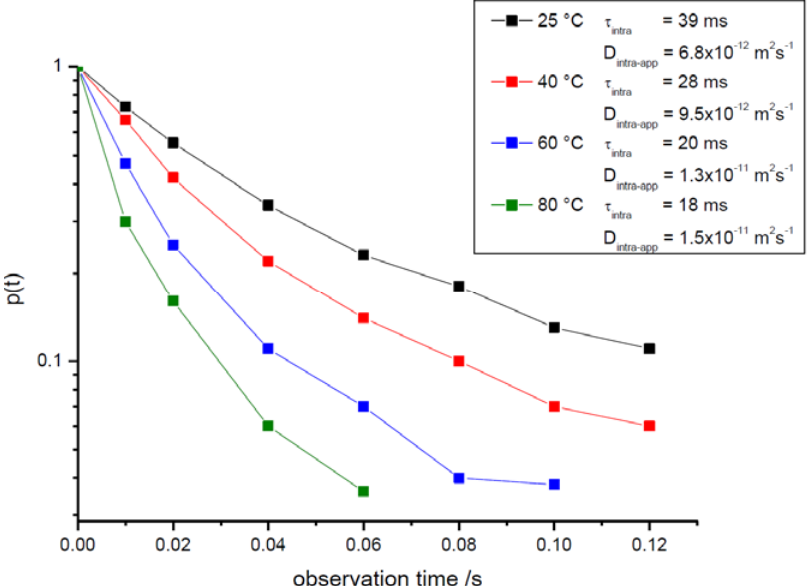
Figure 10. NMR tracer desorption curves for propane in mesoporous zeolite NaCa-LTA-2 for different temperatures. Indicated in the inset are the intracrystalline mean lifetimes following by applying Equations (10) and (12). Also shown are the (apparent) diffusivities which result via Equation (11) with the microscopically determined crystallite radius of about 2 μ m if the tracer desorption curves were analyzed by implying diffusion-limited tracer